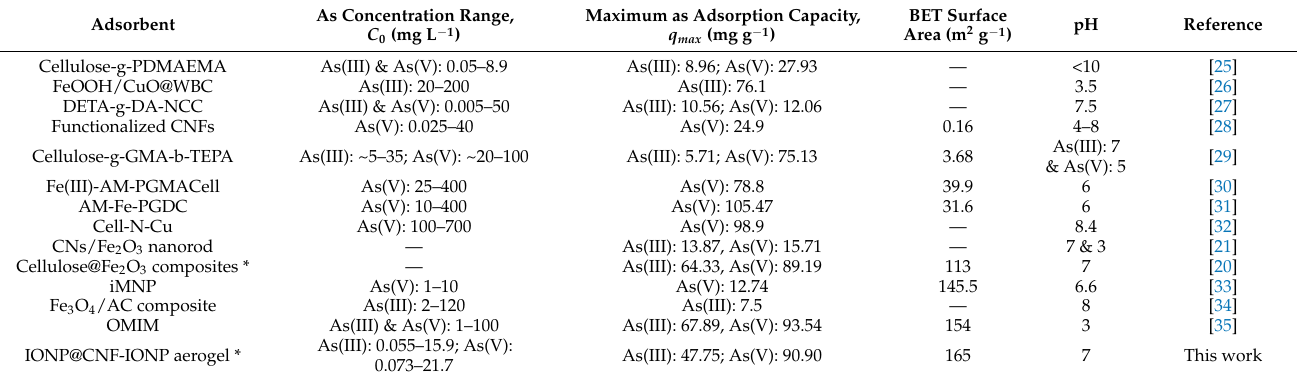
Abbreviations: Cellulose-g-PDMAEMA: native cellulose fibers modified with poly(N,N-dimethyl aminoethyl methacrylate), FeOOH/CuO@WBC: iron(III) oxyhydroxide/copper oxide composite based on water bamboo cellulose, DETA-g-DA-NCC: diethylene tri- amine grafted dialdehyde nanocrystalline cellulose, Functionalized CNFs: cellulose nanofibrils modified with trimethylammonium chloride, Cellulose-g-GMA-b-TEPA: glycidyl methacrylate grafted cellulose modified with tetraethylenepentamine, Fe(III)-AM-PGMACell: iron(III)- coordinated amino-functionalized poly(glycidyl methacrylate)-grafted cellulose, AM-Fe-PGDC: Fe(III)-coordinated amino-functionalized poly(glycidylmethacrylate)-grafted TiO 2 -densified cellulose, Cell-N-Cu: copper containing modified cellulose, CNs/Fe 2 O 3 nanorod: cellulose nanocrystals/iron oxide nanorod composite, Cellulose@Fe 2 O 3 composites: composite material containing magnetic Fe 2 O 3 and cellulose iMNP: magnetic nanoparticles prepared from iron containing sludge, Fe 3 O 4 /AC composite 3 : iron oxide/commercial activated carbon composite, OMIM: mesoporous iron manganese bimetal oxides. * The maximum adsorption capacities are based on the iron oxide only. The pH-dependent dissolved arsenic speciation affects its adsorption behavior. Figure